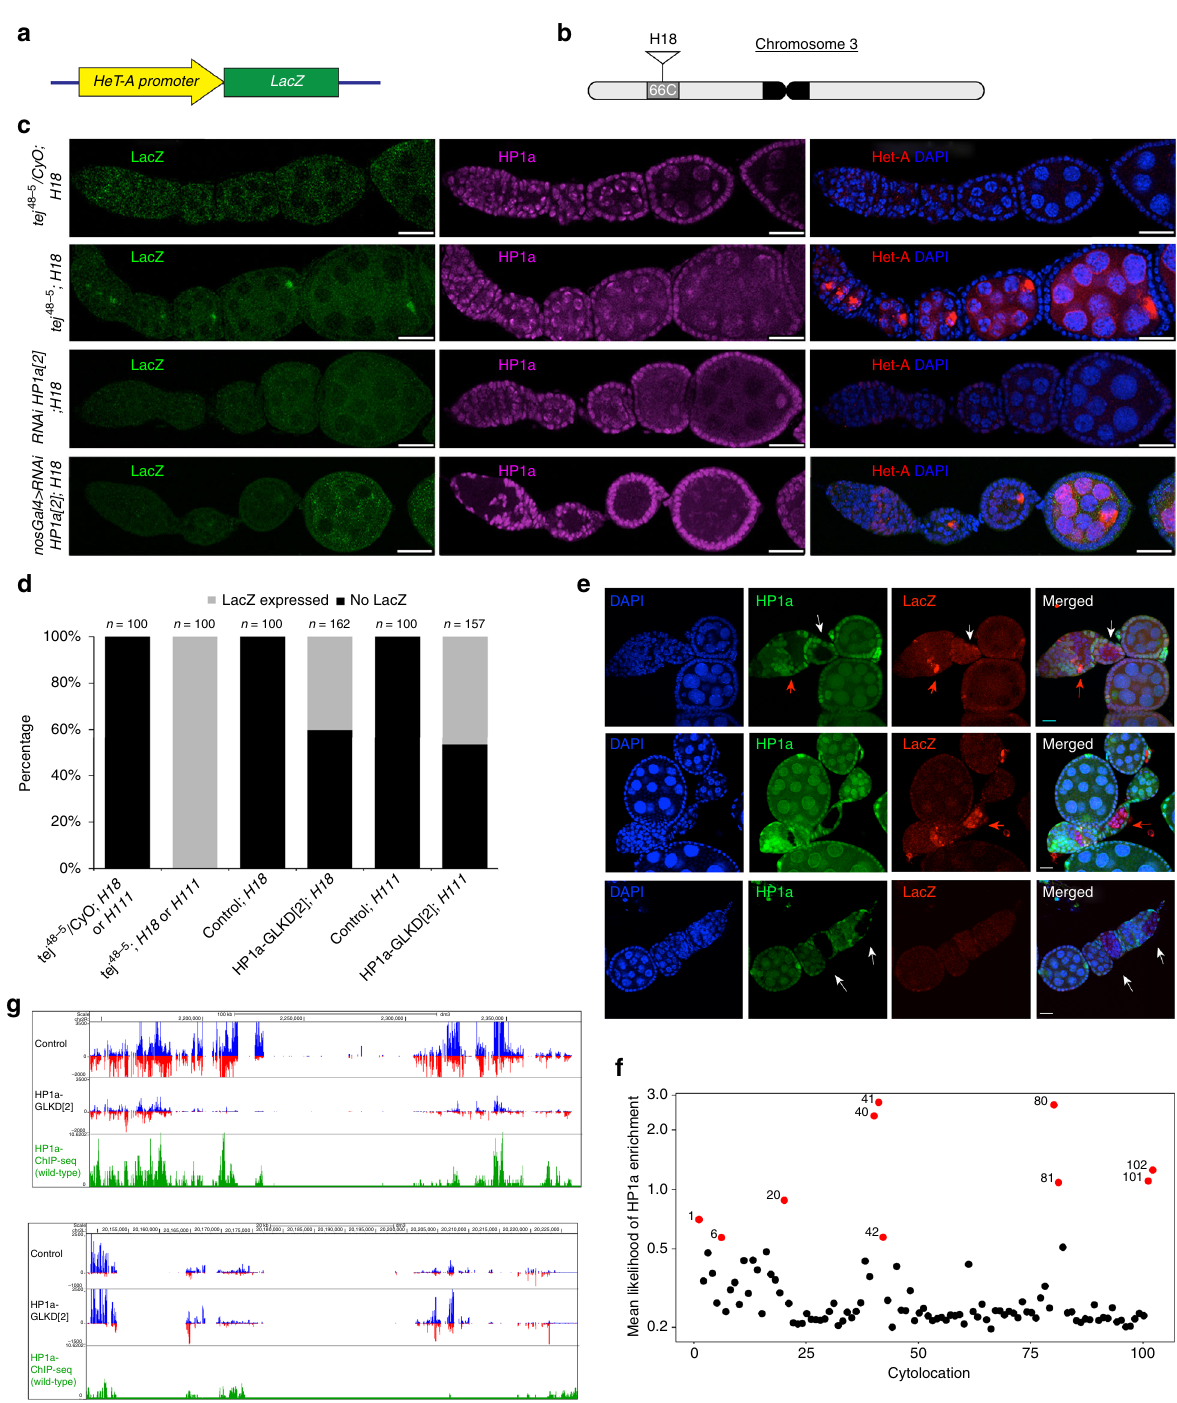
Fig. 3 HP1a represses Het-A in a location-dependent manner a Schematic representation of the HeT-A/lacZ reporter construct. The HeT-A promoter is fused to the lacZ gene. b Schematic representation of the HeT-A/lacZ reporter insertion at the cytological position 66C (H18). c Representative confocal images of HP1a, LacZ, and HeT-A immunostaining in tej 48-5 /CyO, tej 48-5 , and HP1a-GLKD ovaries. All genotypes harbour the HeT-A/lazZ transgene (H18 line). Three independent experiments were performed. Scale bars = 25 μ m. d Bar graph showing the percentage of ovarioles expressing LacZ in tej 48-5 / CyO, tej 48-5 , and HP1a-GLKD genotypes bearing the HeT-A/lacZ transgene (H18 and H111). LacZ positive and negative ovarioles are represented by black and grey, respectively. n represents the number of ovarioles counted ( n ≥ 100, from three independent experiments). e Representative confocal images of LacZ and HP1a immunostaining in the mitotic clones lacking HP1a. Red arrows and white arrows denote the HP1a clones with LacZ and those without LacZ expression, respectively. Scale bars = 15 μ m. Three biological replicates were examined. f Scatterplot showing the mean likelihood of HP1a enrichment on chromosomal arms. Cytolocations marking telomeres and centromeres are represented in red. g UCSC browser screenshot showing the changes in total piRNAs and HP1a enrichment, following the normalisation with reads in the IgG ChIP-seq library, at cluster 42AB (upper panel) and cluster 38C (lower panel) in the control and HP1a-GLKD